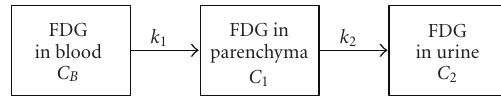
Figure 1: Model of kidney for FDG